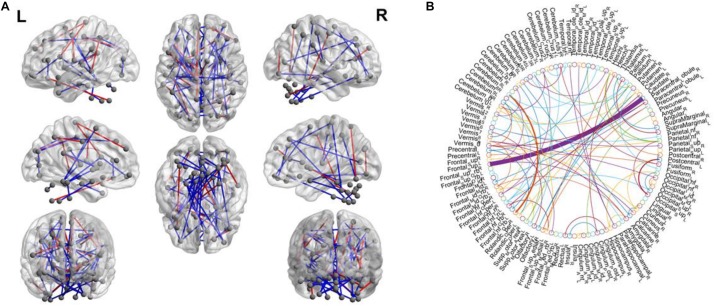
(A) The most significant functional connections mapped on the ICBM 152 template using the BrainNetViewer package (http://nitrc.org/projects/bnv/). The green and red lines represent connection weights that are decreased and increased in MCIs, respectively. (B) The consensus connections, selected via LOOCV, between MCI and NC for 116 AAL template ROIs. The arc thickness indicates the discriminative power of an edge, which is inversely proportional to the estimated p-values. This figure was created using a Matlab function, circularGraph, shared by Paul Kassebaum (http://www.mathworks.com/matlabcentral/fileexchange/48576-circulargraph).